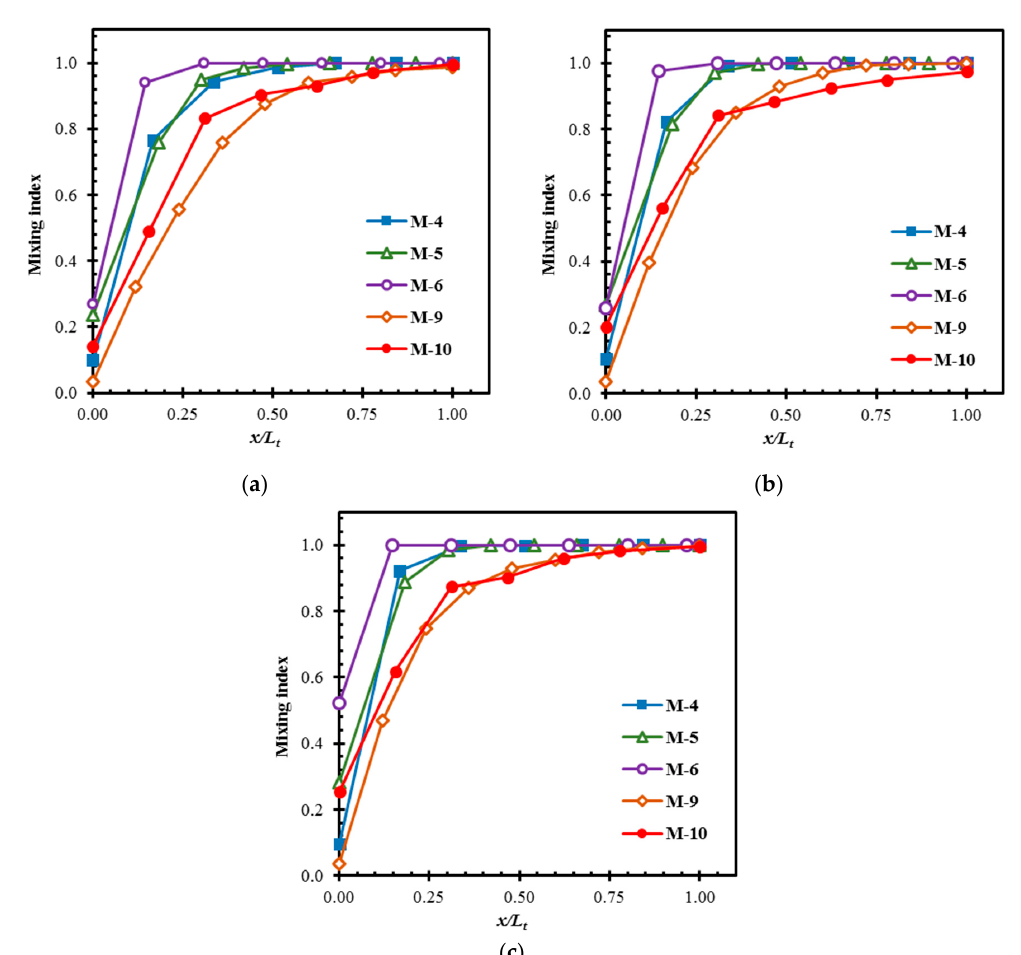
Figure 14. Developments of mixing along the length of the micromixers: ( a ) Re = 60, ( b ) Re = 80 and ( c ) Re = 120.